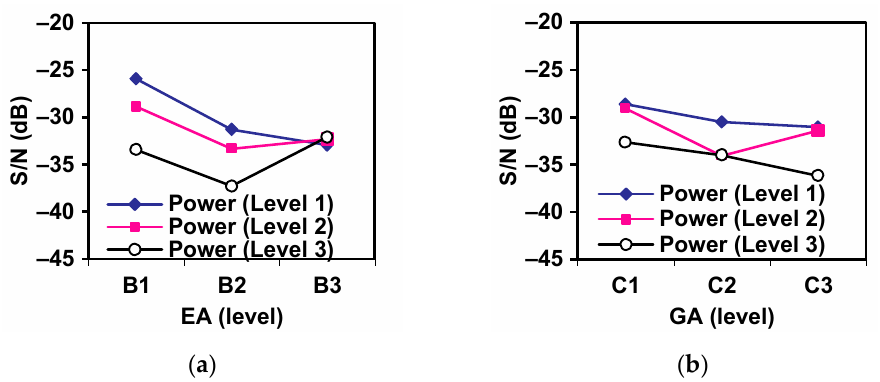
Figure 9. Indices of interaction between factors (T at 5 mm) S/N values for: ( a ) each EA level at different power levels; ( b ) each GA level at different power levels.